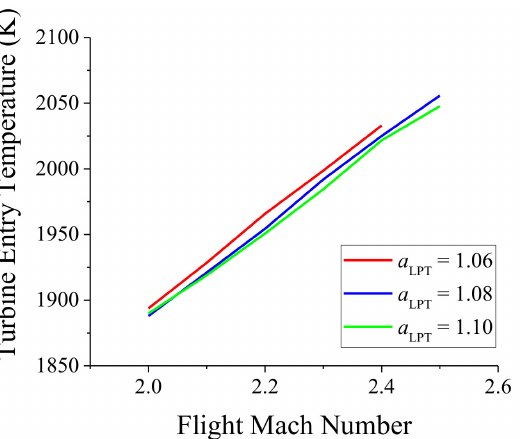
Figure 36. The Variations of Turbine Entry Temperature at the conditions of Different Throat Area Coefficients of Low-Pressure Turbine Inlet Guide Vane ( α LPT ).